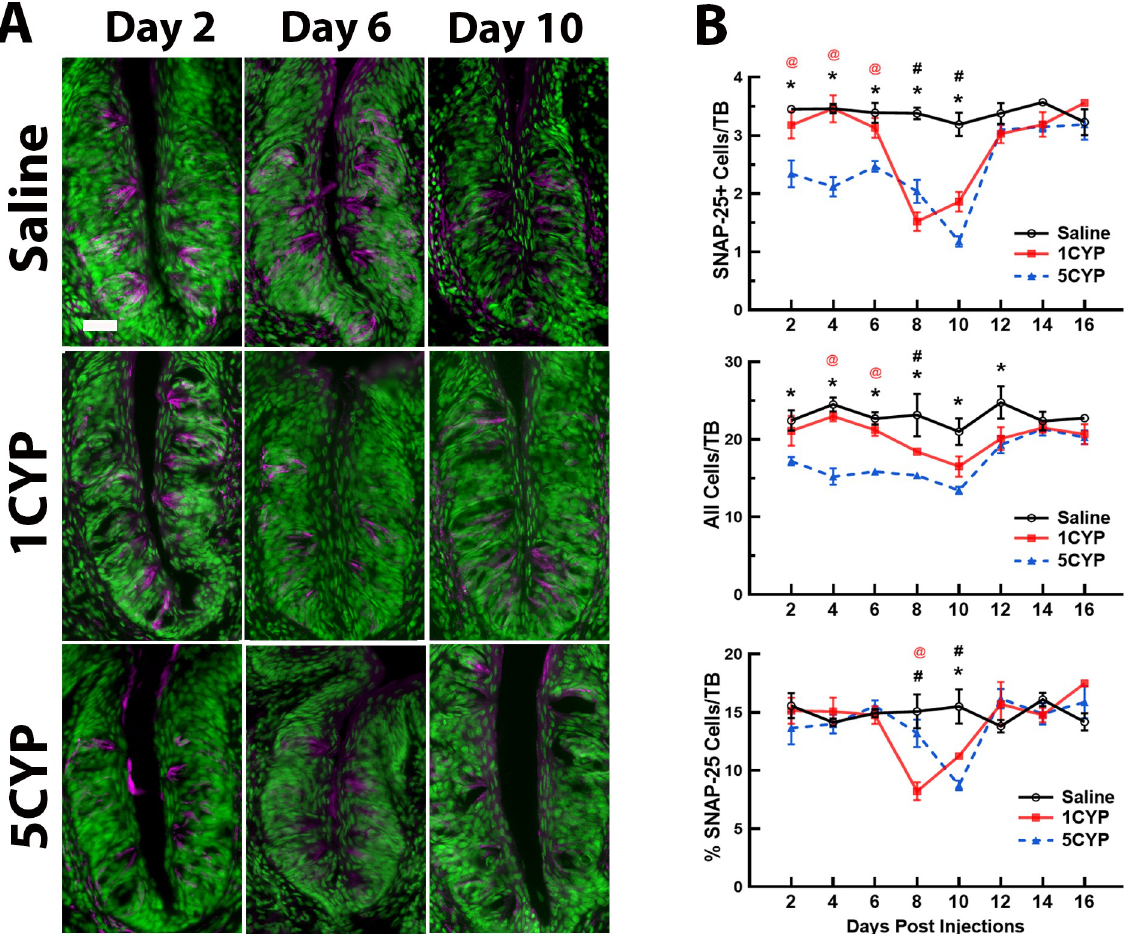
Fig 3. CYP dosing conditions differentially altered SNAP-25 expression in circumvallate taste buds. (A). SNAP-25+ cells (magenta) in taste buds after saline injections (Saline, top row), a single injection of 75 mg/kg CYP (1CYP, middle row), or five injections of 15 mg/kg CYP (5CYP, bottom row) at 2 days (left column), 6 days (middle column), and 10 days (right column) post injection. Tissues were counter-reacted with Sytox green, a nuclear marker. For 1CYP mice, the number of SNAP-25+ cells were lower 8 and 10 days after injection. For the 5 CYP mice, SNAP-25+ labeling was suppressed 6–10 days post injection. Scale bar = 20 μ m. (B) Means ± SEM of SNAP-25+ cells (top graph), total cells (middle graph), and percent of SNAP-25+ cells per taste bud (bottom graph) are plotted over days post injection. For 1CYP mice, SNAP- 25+ signal, total cell number, and percent labelled cells were significantly lower than saline control mice at 8 and 10 days after CYP injection. For 5CYP mice, SNAP-25+ and total number of cells per taste bud were lower than saline controls 2–10 days post injection and lower than 1CYP mice at 2–6 days post injection. The percent of SNAP-25+ labeled cells per taste bud in 5CYP mice was higher than 1CYP mice at 8 days and lower than controls at 10 days after injection. All Ps < .05 or less: (1) � 5CYP < Saline, (2) # 1CYP < Saline, and (3) @ 5CYP <